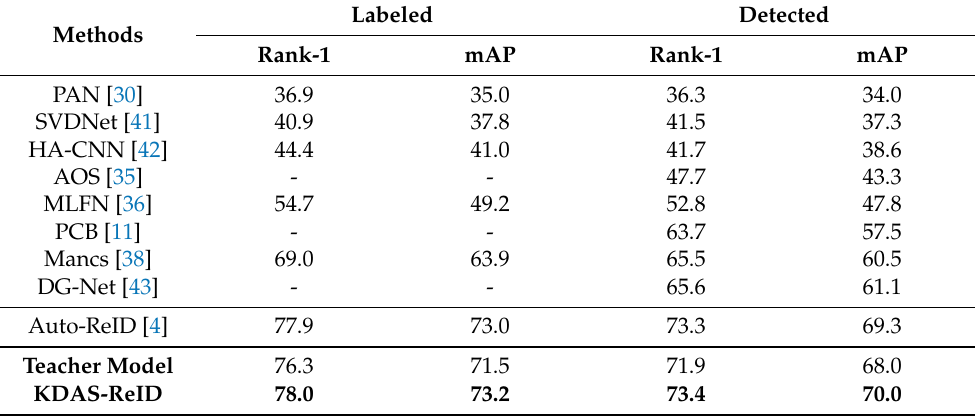
Table 3. We use the new evaluation protocol in [30] to evaluate on the data set CUHK03. We compare with the most advanced Re-ID model in terms of Rank-1 accuracy and mAP. We have boldfaced the best results in the table.